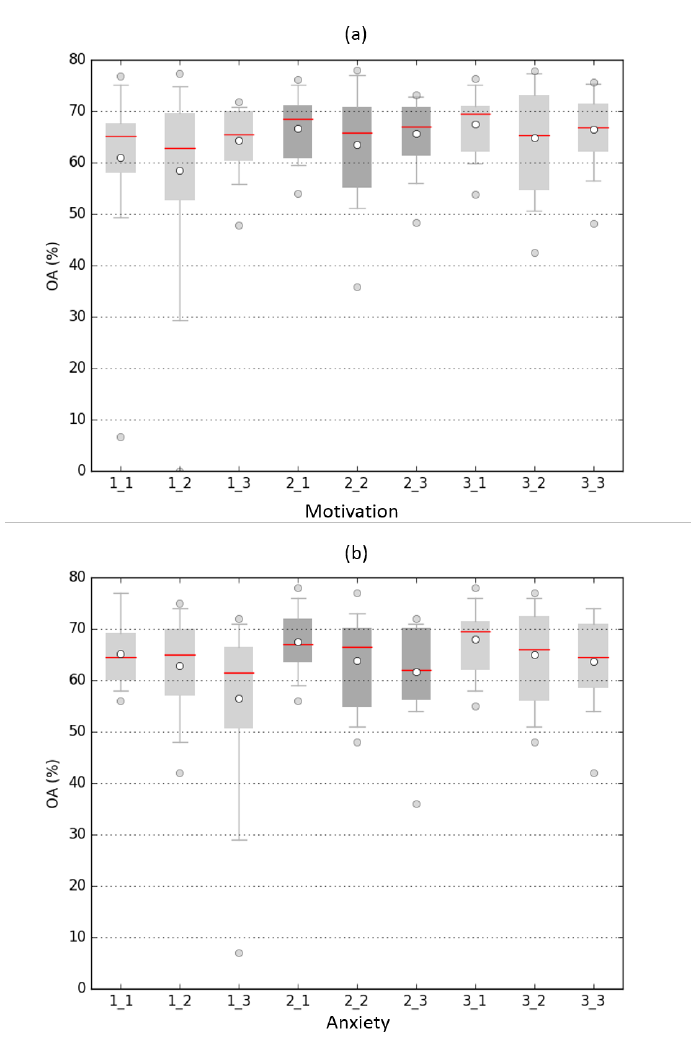
Figure 6. Boxplots of overall accuracies depending on iteration and group ( a ) motivation and ( b ) comparative anxiety. The x-axis ticks are formatted as X _ Y with X the iteration number and Y group number. Median OA: red stripe; average OA: white dot; boxplot ends: first and third quantile; whiskers: + / − the 1.5-fold interquartile range on OA values and outliers: grey